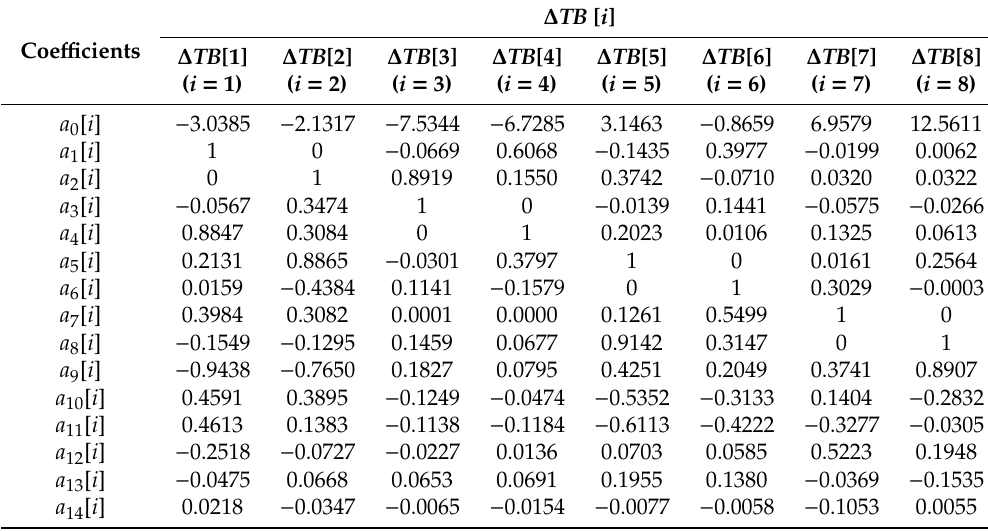
Table 1. Coe ffi cients developed for ocean surface in Equation